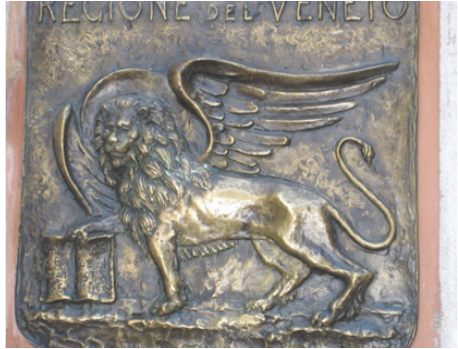
Figure 1: Venice lion insignia. Photo ©